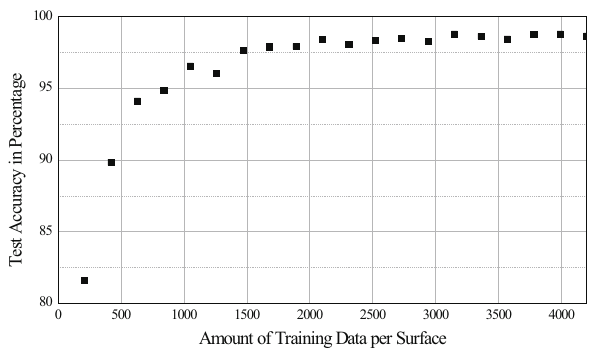
Figure 8. Test accuracy as a function of the amount of training data per surface, using the 1D-CNN classifier.